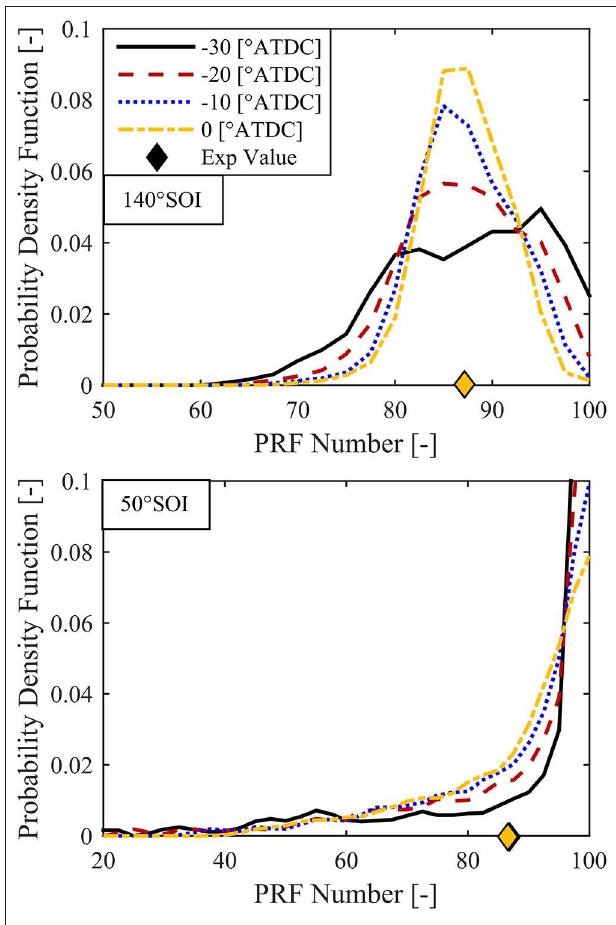
FIGURE 7 | PDFs of PRF number for two SOI cases, − 140 ◦ SOI (Top) , and − 50 ◦ SOI (Bottom) , for various crank angles, showing the mixing of the fuel over